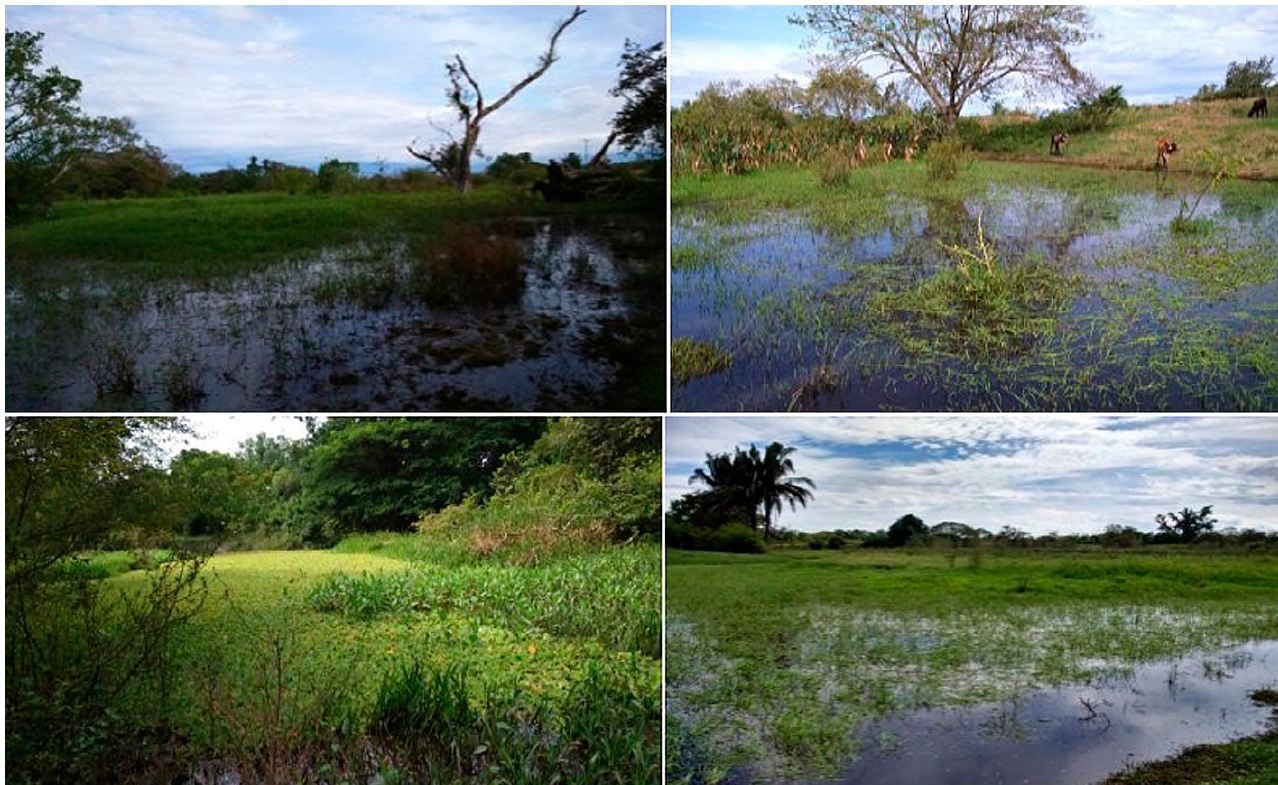
Figure 2. Azuceno Wetland, Guamo municipality, Tolima Department, Colombia.